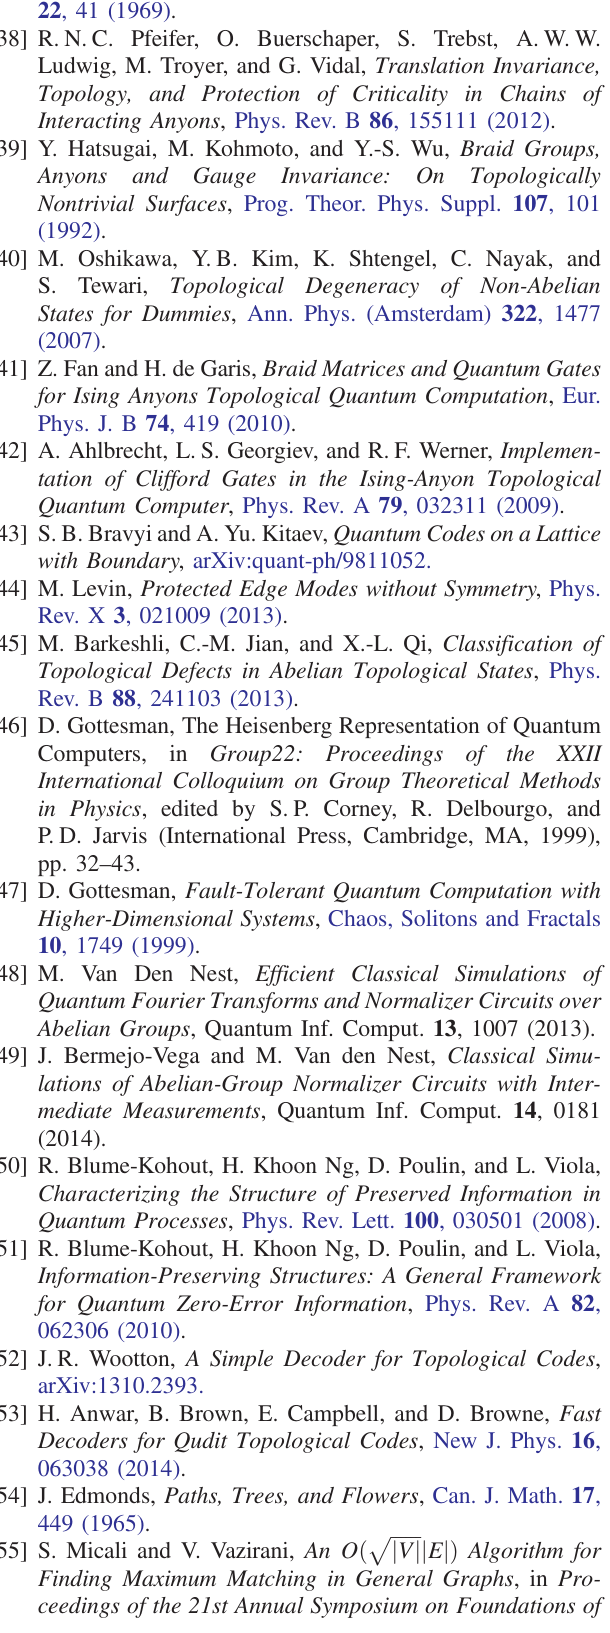
j E jÞ Algorithm for